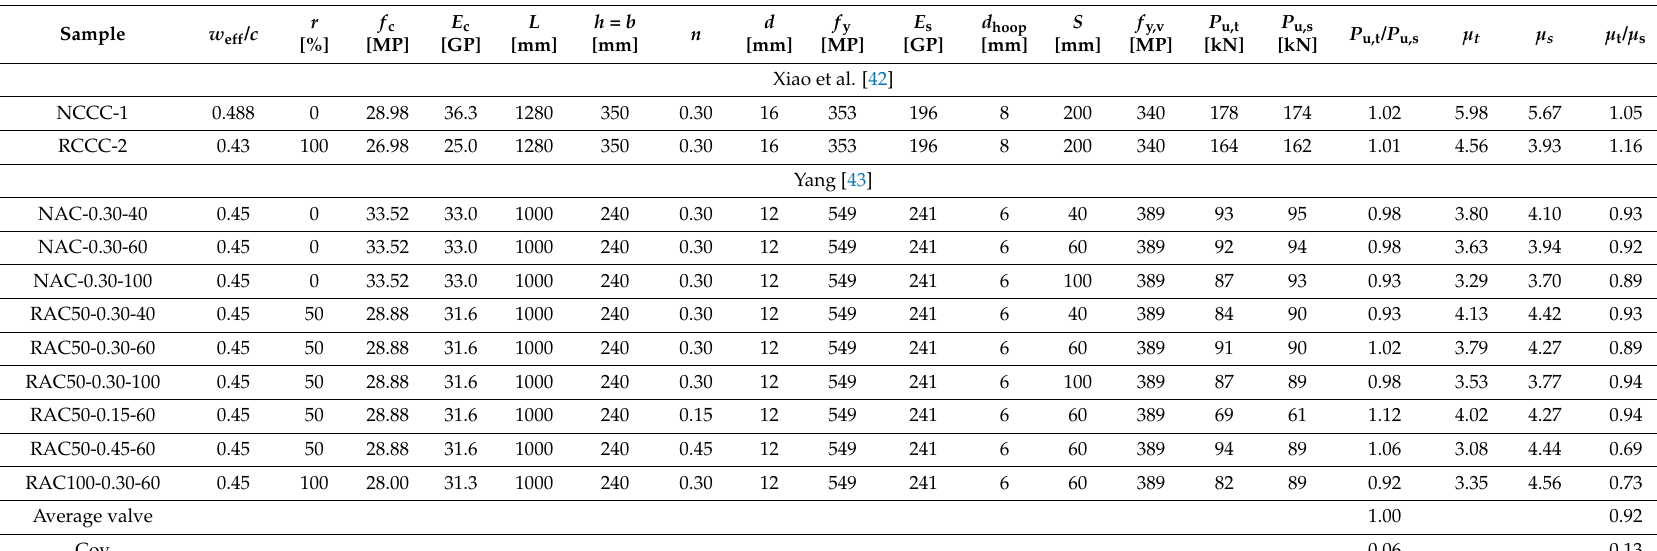
Table 1. Experimental information of RRC specimens collected from